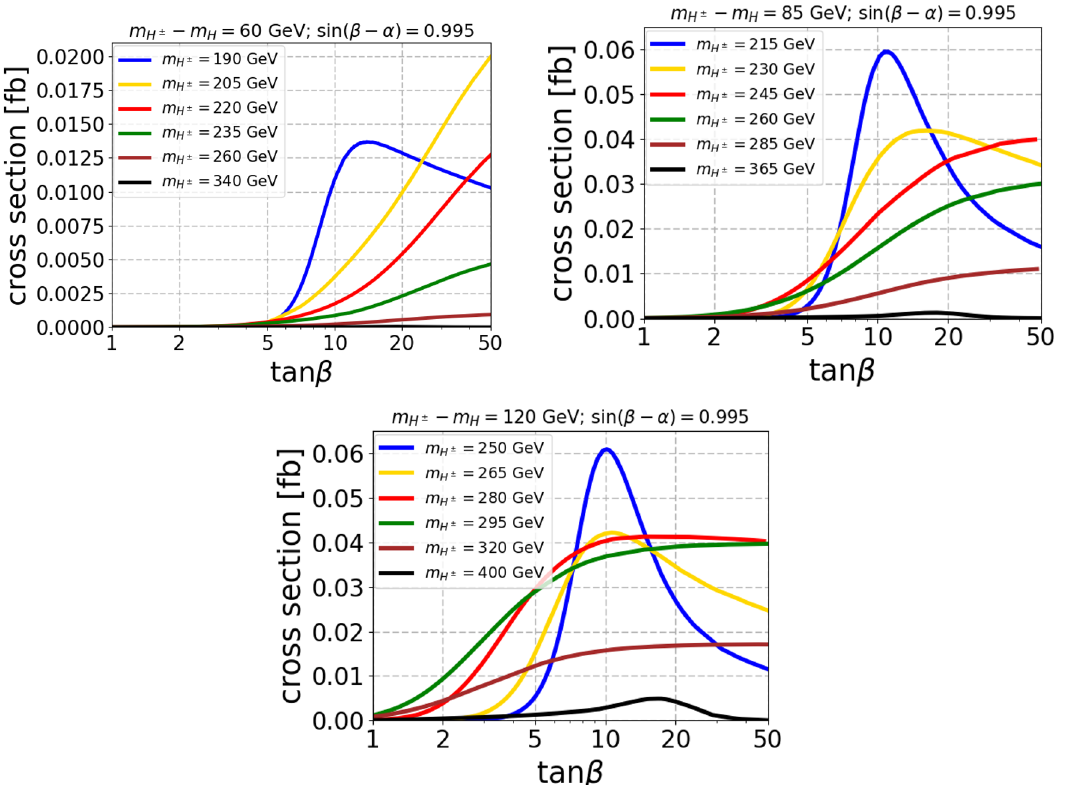
Figure 4 . The same sign trilepton (SS3L) signal cross-sections after all cuts is plotted against tan β for different charged Higgs masses with three mass differences, 60 GeV (top left) 85 GeV (top right), 120 GeV (bottom) and sin( β − α ) = 0 . 995 . Please refer to text for the explanation of different curves.